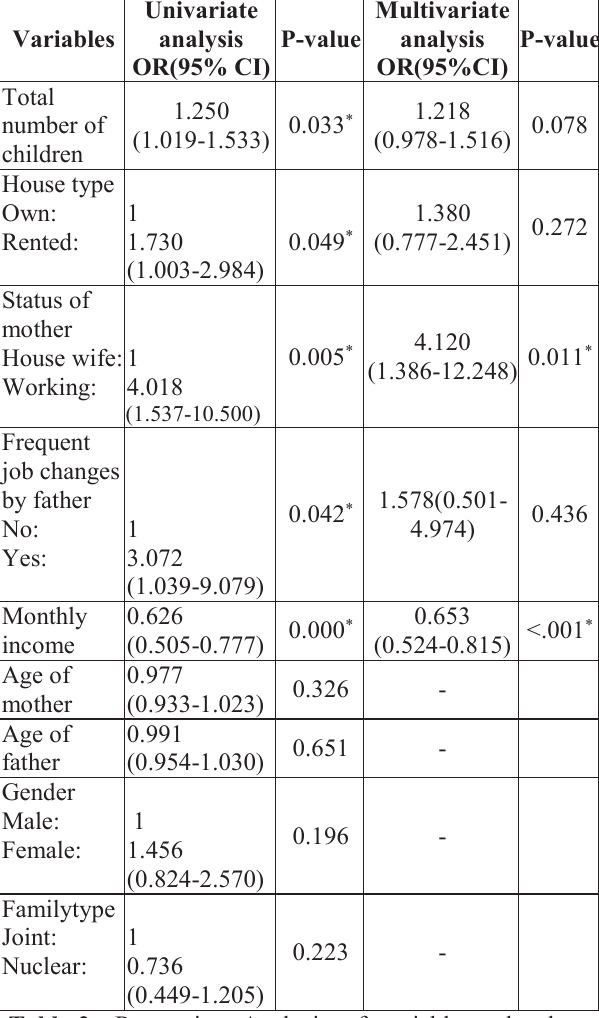
Table-2: Regression Analysis of variables related